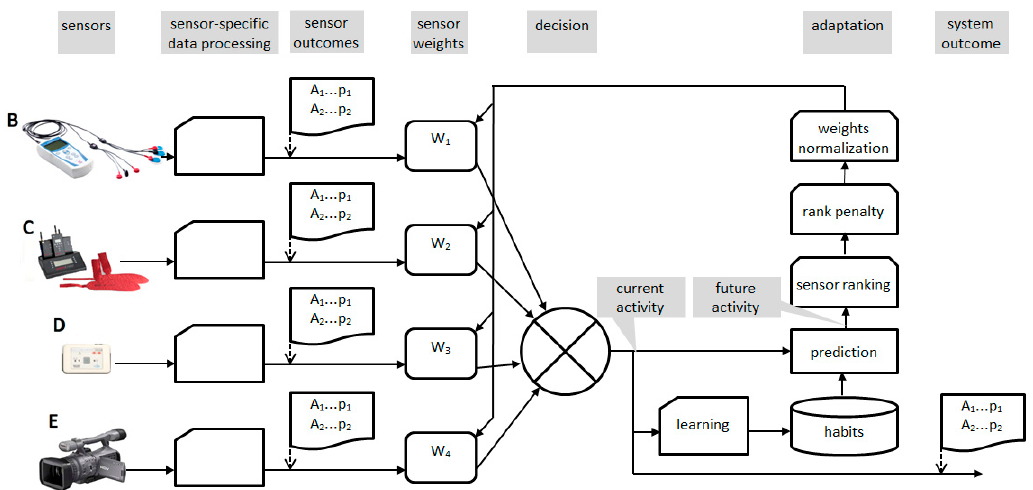
Figure 7. Flow of sensors’ data modulator adapting a multimodal assisted living system to most probable future behavior.